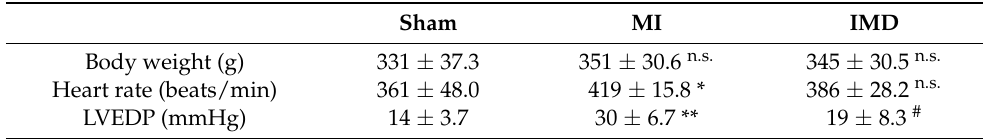
Values are presented as the mean ± SD. * p < 0.05 vs. the sham rats, ** p < 0.01 vs. the sham rats, # p < 0.05 vs. the MI rats; n.s., no significance. LVEDP, left-ventricular end-diastolic pressure; MI, myocardial infarction; IMD, intermedin